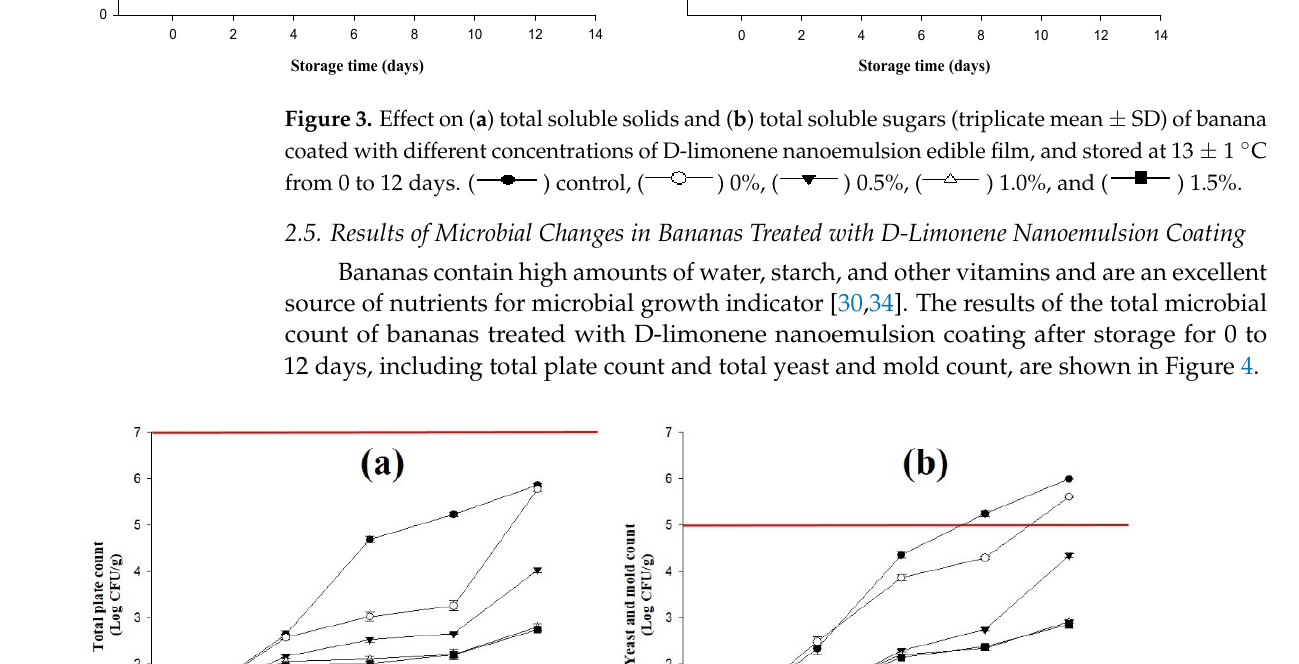
Figure 3. Effect on ( a ) total soluble solids and ( b ) total soluble sugars (triplicate mean ± SD) of ba- nana coated with different concentrations of D-limonene nanoemulsion edible film, and stored at 13 ± 1 °C from 0 to 12 days. (